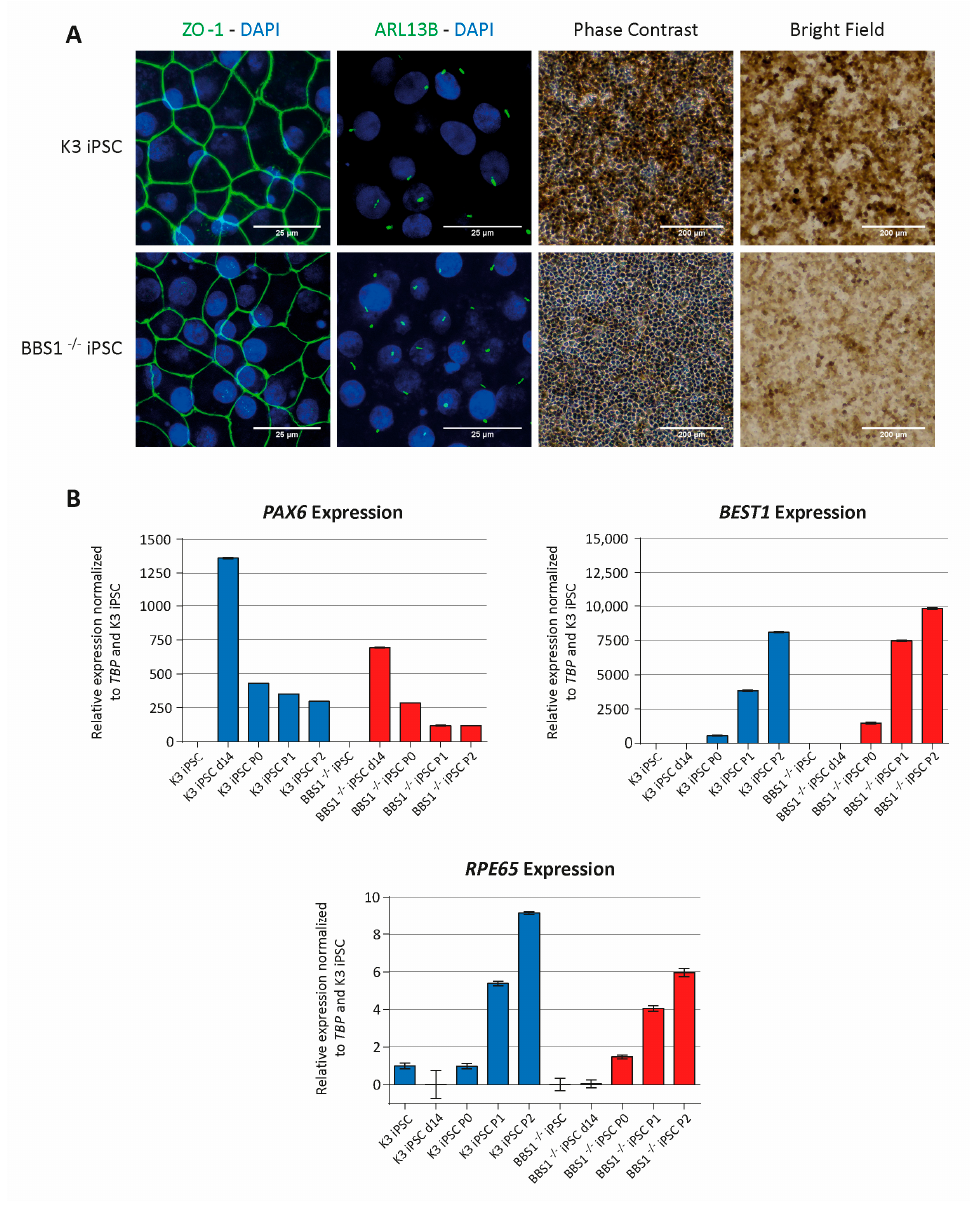
Figure 4. Differentiation of BBS1-iPSC into RPE-like cells. Control K3 iPSC and BBS1 − / − iPCS were analyzed for RPE phenotype, after differentiation for 110 days (end of P2). ( A ) IFM after incubation with antibodies against ZO-1 (tight junction marker) and ARL13B (Cilia marker). Nuclei were visualized with 4 (cid:48) ,6-diamidino-2-phenylindole (DAPI) staining (Panels 1 and 2), scale bar 25 µ M. Phase contrast pictures (Panel 3), scale bar 200 µ M. Bright-field images (Panel 4), scale bar 200 µ M. Both control K3 iPSC and BBS1 − / − iPCS were able to form tight junctions (Panel 1) and primary cilia (Panel 2). The cells had obtained the characteristic cobblestone morphology of RPE cells (Panel 3). Both cell-lines became pigmented (Panel 4). ( B ) Gene Expression. mRNA was isolated at different time points during the differentiation process and quantitative Polymerase Chain Reaction (qPCR) was performed. mRNA was isolated at day 0 (iPSC clone), day 14 after initiation of differentiation (d14) and at the end of the three passages, P0, P1 and P2. Expression profile of PAX6 (retinal precursor marker), BEST1 (mature RPE marker) and RPE65 (mature RPE marker) was normalized to the expression of the endogenous TBP gene encoding the TATA-box binding protein. Data derived from one experiment (technical triplicates); no statistics